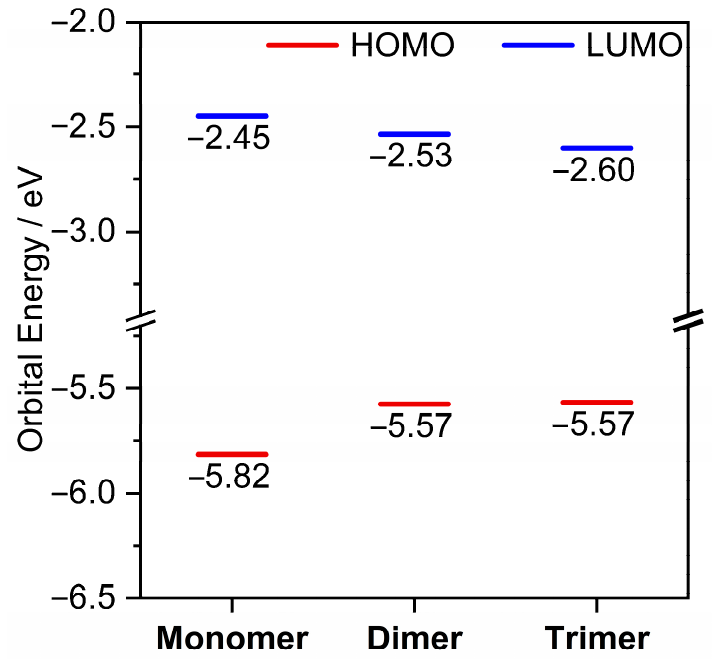
Figure 1. The HOMO and LUMO levels of the monomer, dimer, and trimer calculated at B3LYP/6-31+G(d,p) (monomer) and B3LYP/6-31+G(d,p)//B3LYP/6-31G(d,p) (dimer and trimer) levels of theory.